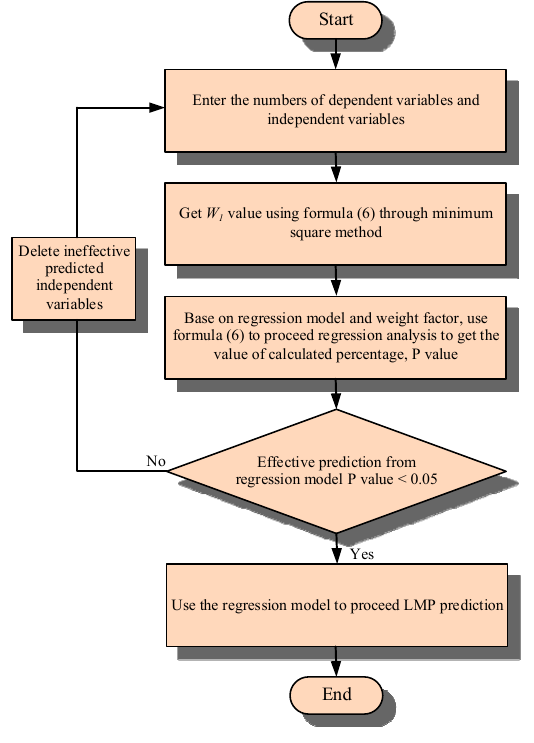
Figure 4. Regression model forecasting procedure.